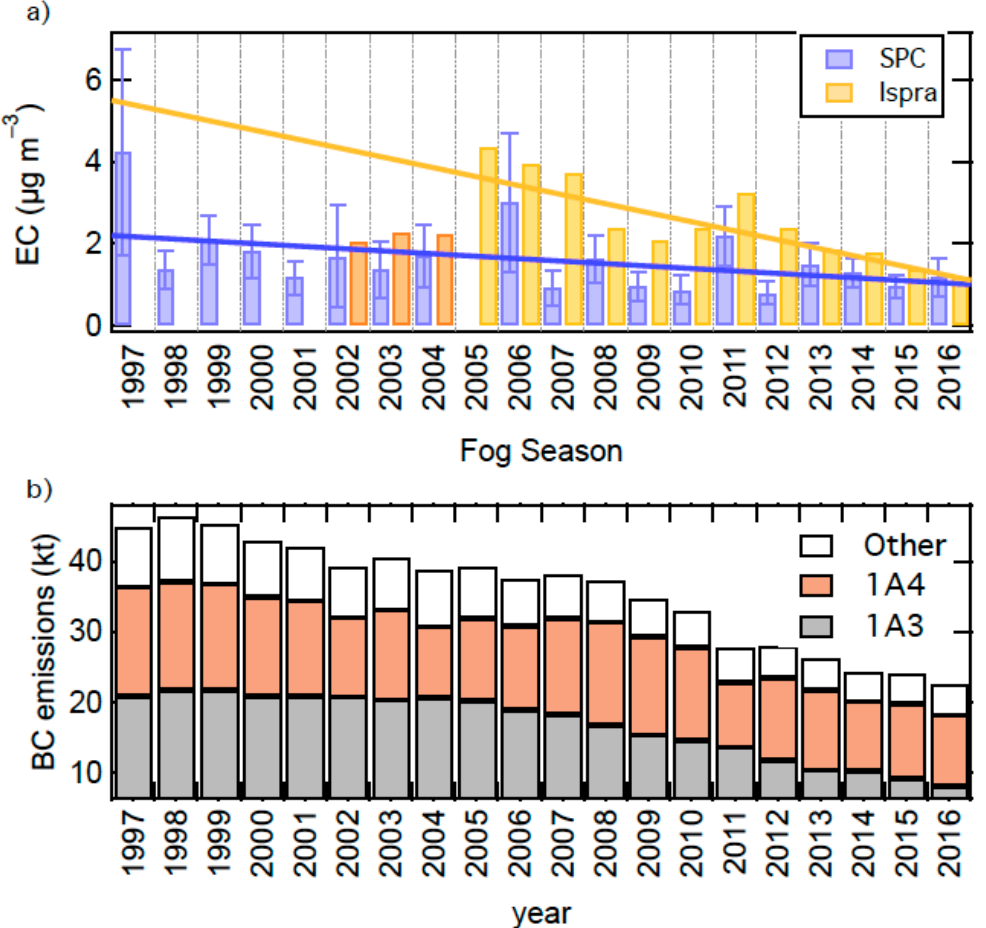
Figure 5. ( a ) Trend of atmospheric EC average concentration estimated from fog water composition in SPC (blue bars) and from direct EC measurements in Ispra from November to March of the following year (dark orange bars for 2002–2004 seasons, and light orange bars for 2005 and following seasons); ( b ) trend of national black carbon emissions from 1997 to 2016, compiled by the Institute of Environmental Protection and Research (ISPRA); contributions from non-industrial combustion (1A4 in brown) and road transport (1A3 in grey) are highlighted. Table 2. Statistical parameters of Kendall rank correlation and Theil-Sen analysis for the EC time series at San Pietro Capofiume (SPC 1997–2016) and Ispra (2003–2016). Kendall’s